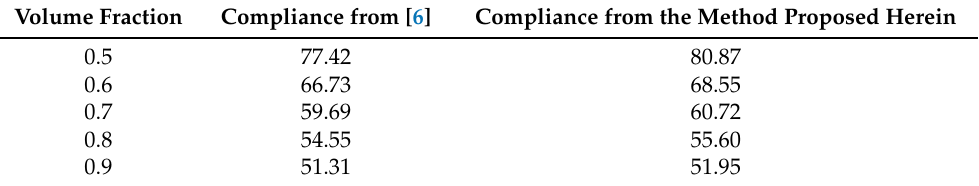
Table 2. Half-MBB beam compliance for different volume fractions from the literature and the proposed method.